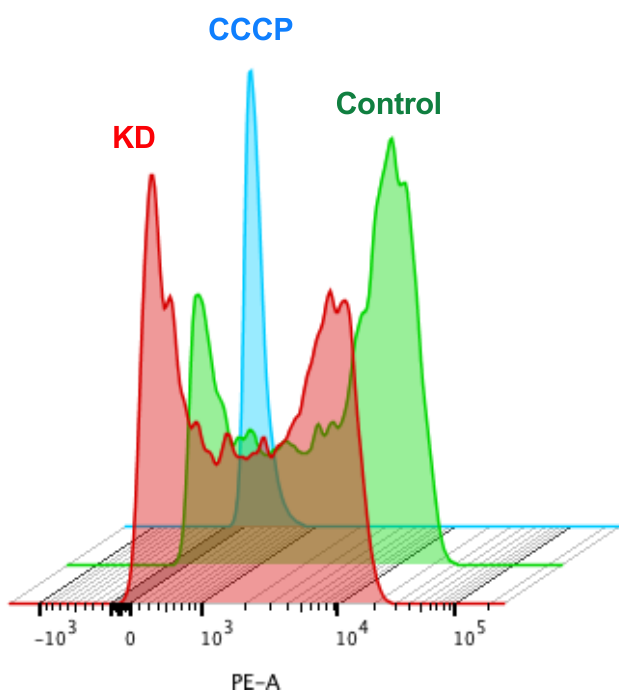
Figure 7. The absence of Kv10.1 results in a decrease in mitochondria potential. HeLa cells were transfected with siRNA for Kv10.1 and 48 h later treated with Rhodamin 6G. The mitochondrial membrane potential was measured using flow cytometry. The histogram presented is representative of three independent experiments. KD cells (red) were more depolarized then controls (green). The blue histogram represents cells whose mitochondria was depolarized by treatment with CCCP.